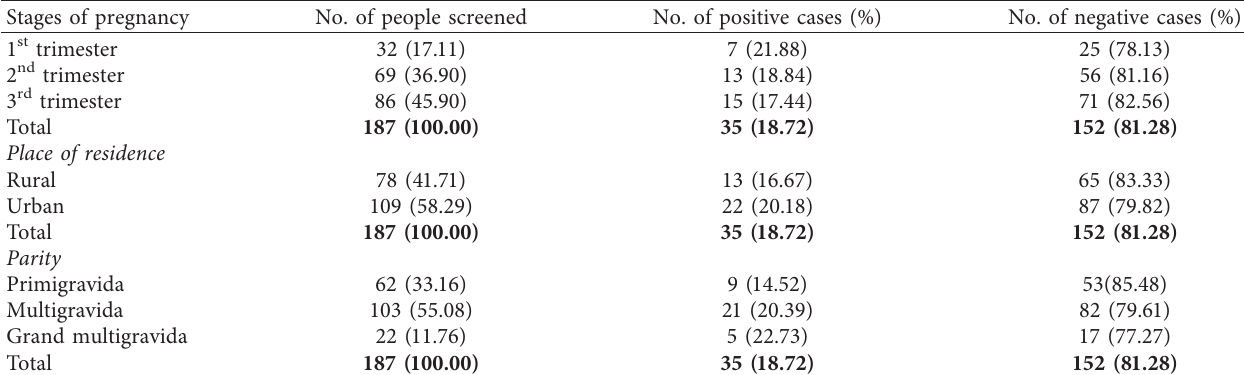
Table 3: Pregnancy stage, residence, and parity spread of the IgM antibody among study